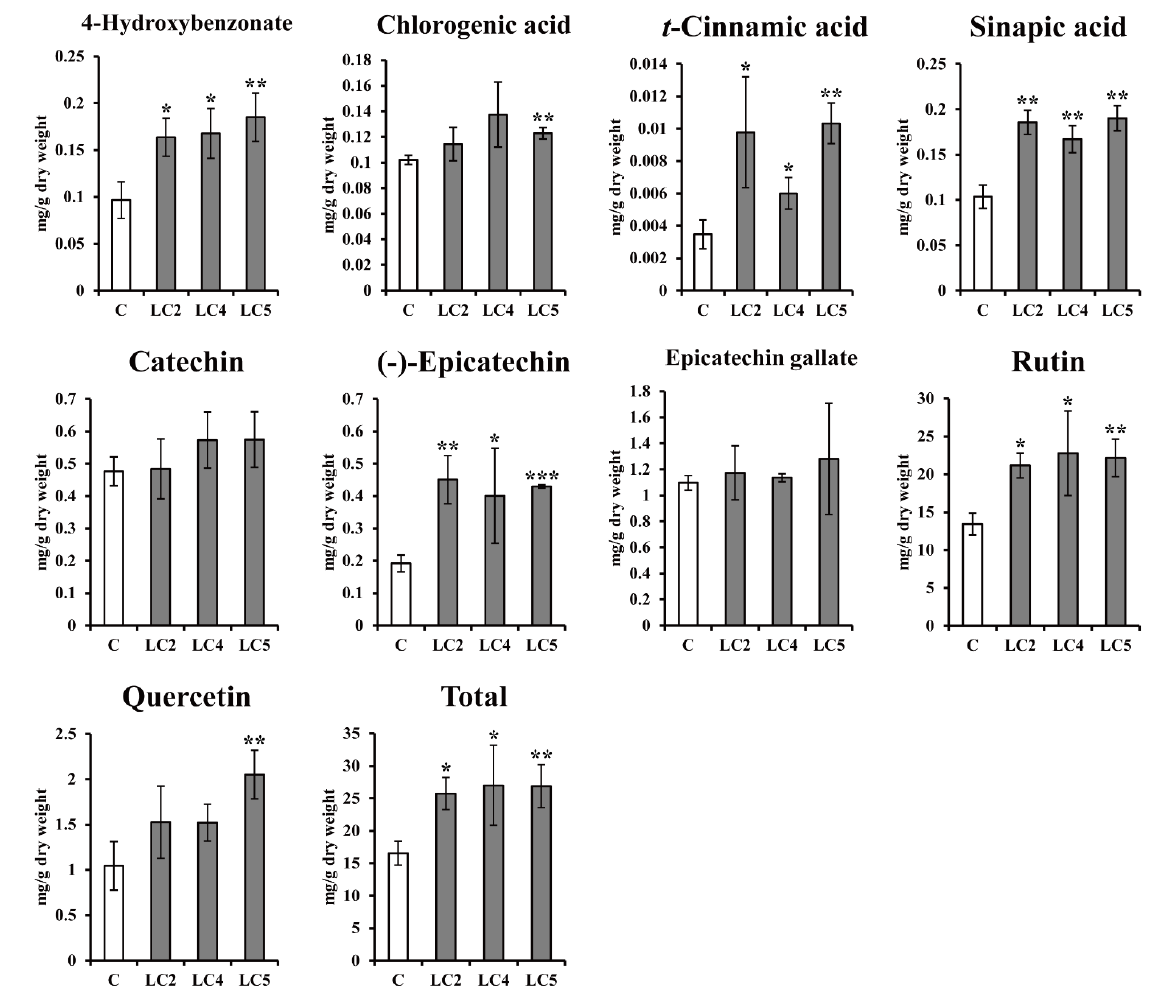
Figure 6. Effect of light treatment on the phenolic compound accumulation of hairy root cultures in Fagopyrum tataricum . C: GUS -overexpressing hairy root line 1; LCn: ZmLC -overexpressing hairy root lines. Asterisks represent statistical significance (* p < 0.05; ** p < 0.01; *** p < 0.001).